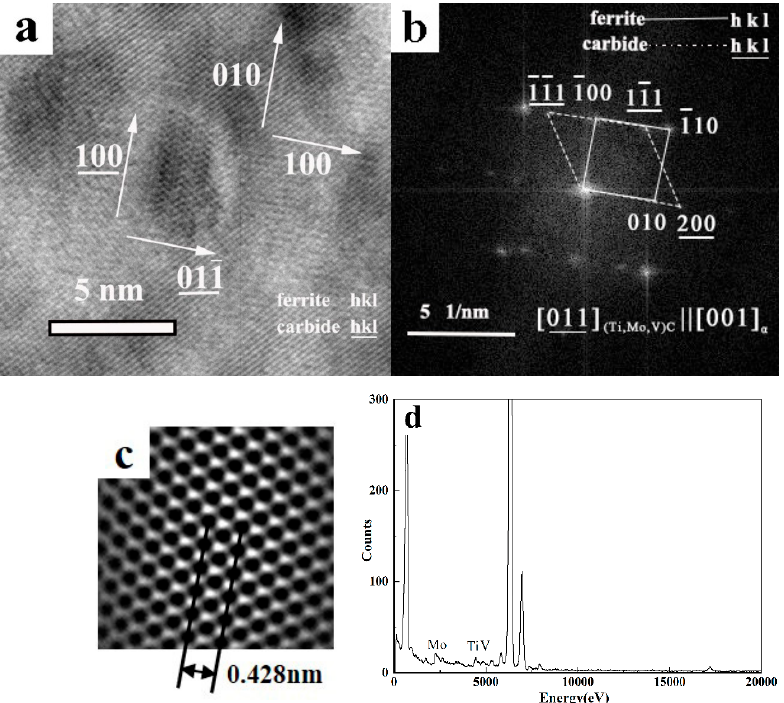
Figure 6. HRTEM images of nanometer-sized carbides in steel LC600. ( a ) High resolution image of interphase precipitation, ( b ) corresponding fast Fourier transformation (FFT) diffractogram, ( c ) inverse fast Fourier transformation (IFFT) lattice image of interphase precipitation, and ( d ) EDS (Energy-dispersive X-ray spectroscopy) analysis of interphase precipitation.